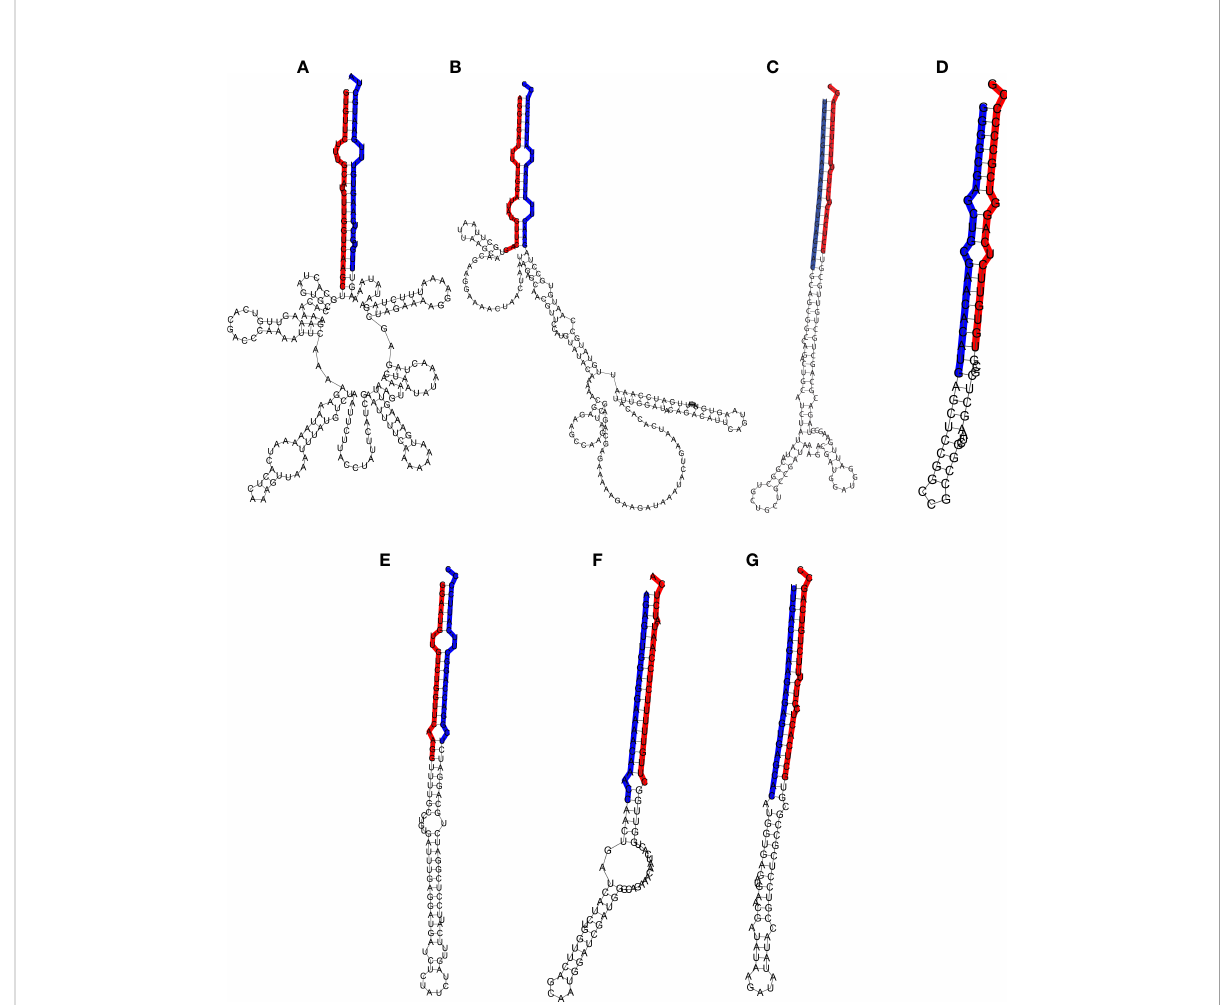
FIGURE 5 Hairpin structure of the miRNA precursors. The mature and star sequences are highlighted in blue and red, respectively. (A) Pre-Ecu-mir novel_1, (B) Pre-Ecu-mir novel_2, (C) Pre-Ecu-mir156c, (D) Pre-Ecu-mir398, (E) Pre-Ecu-mir166, (F) Pre-Ecu-mir 2275c , (G) Pre-Ecu-mir156d (Table